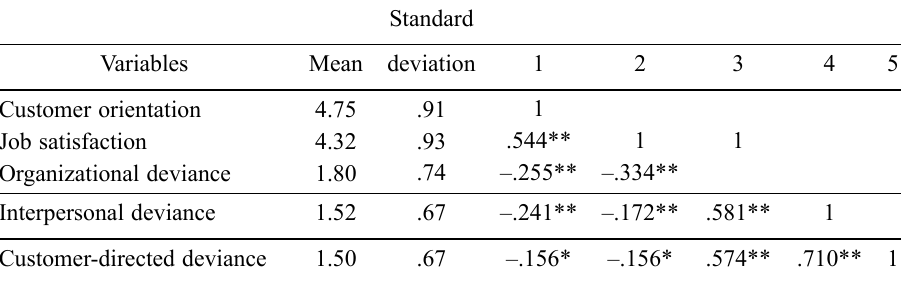
Table 1. Descriptive statistics and variables